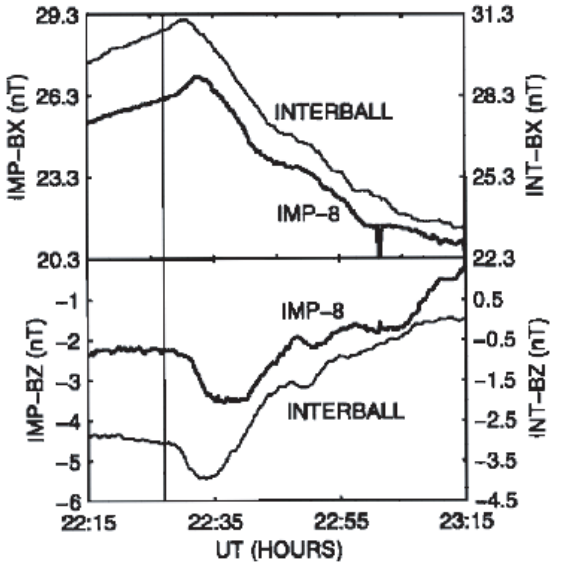
Fig. 15. Tailward propagation of a cross-tail current disruption as evidenced by simultaneous magnetic field measurements taken in the lobe onboard Interball-Tail and IMP-8, separated by about 10 R E along the X axis of the tail. (From Jacquey et al., 1998).